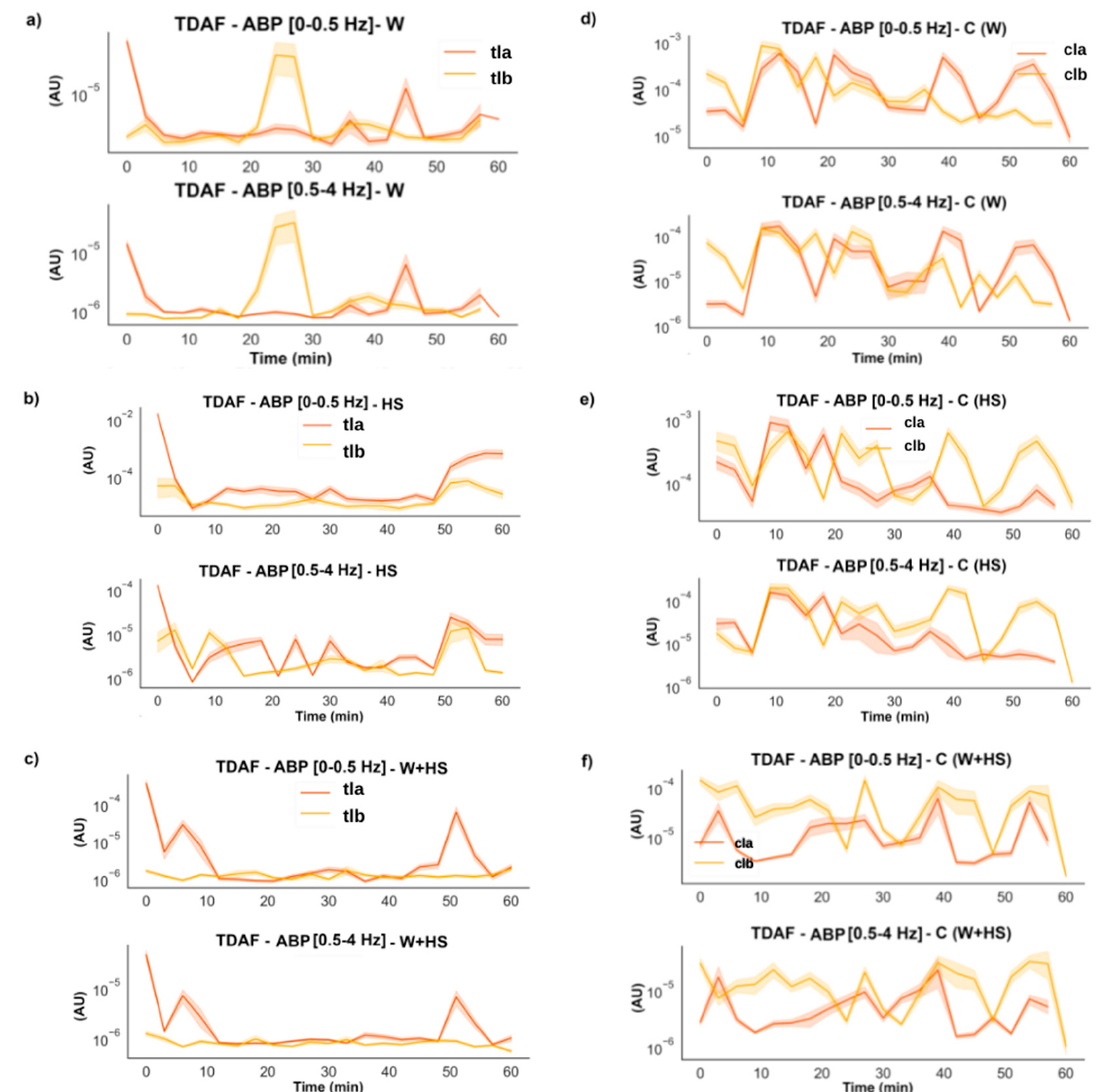
Figure 7. TDAF graphs for ABP analysis for low and Delta frequencies. Results for ( a ) the local wound (W), ( b ) heat shock (HS), and ( c ) wound + heat shock (W+HS). Results of the control plants for ( d – f ) wound C (W), heat shock C (HS), and wound + heat shock C (W+HS), respectively. tlb: treated local before stimulus; tla: treated local after stimulus; clb: control local before stimulus; cla: control local after stimulus. AU: arbitrary unit.